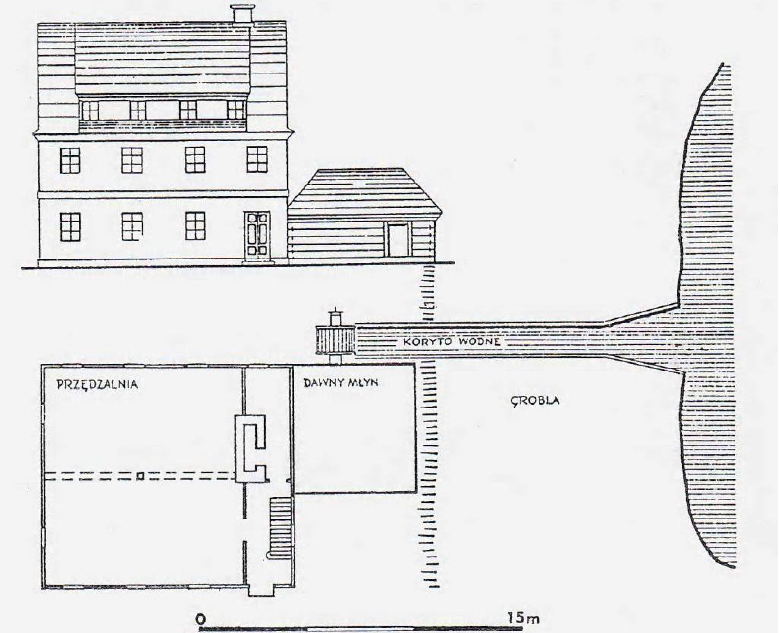
Fig. 4. Wendisch manufacture. Spinning mill built in 1825 in Wójtowski Młyn. Site map copy. AGAD. Collection of maps 30-4. According to I. Popławska (1973)